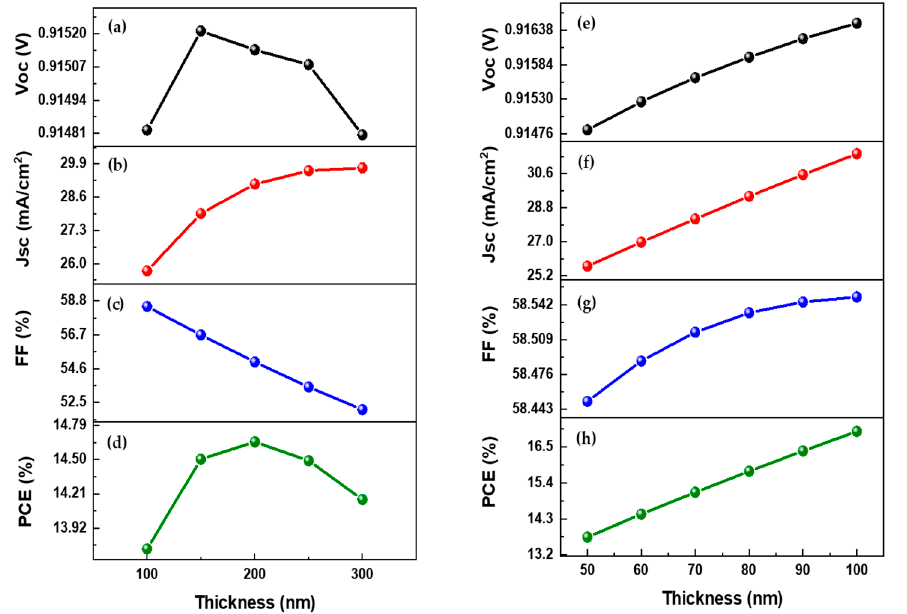
Figure 4. ( a , e ) Voc as a function of active layer and HTM layer thickness; ( b , f ) Jsc as a function of active layer and HTM layer thickness; ( c , g ) FF as a function of active layer and HTM layer thickness; and ( d , h ) PCE as a function of the active layer and HTM layer thickness.